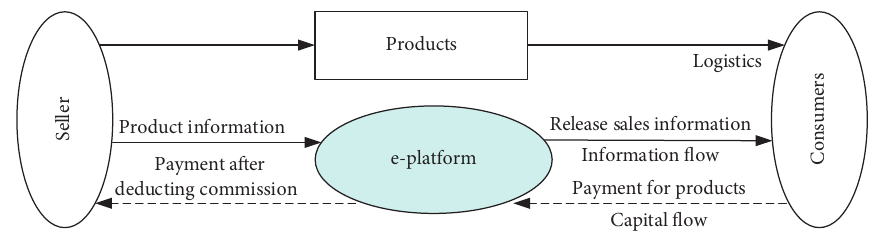
Figure 1: A framework of the